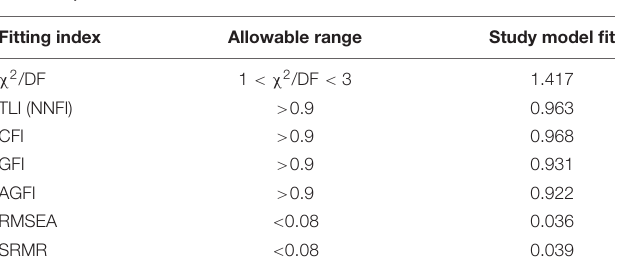
TABLE 3 | Model fit.